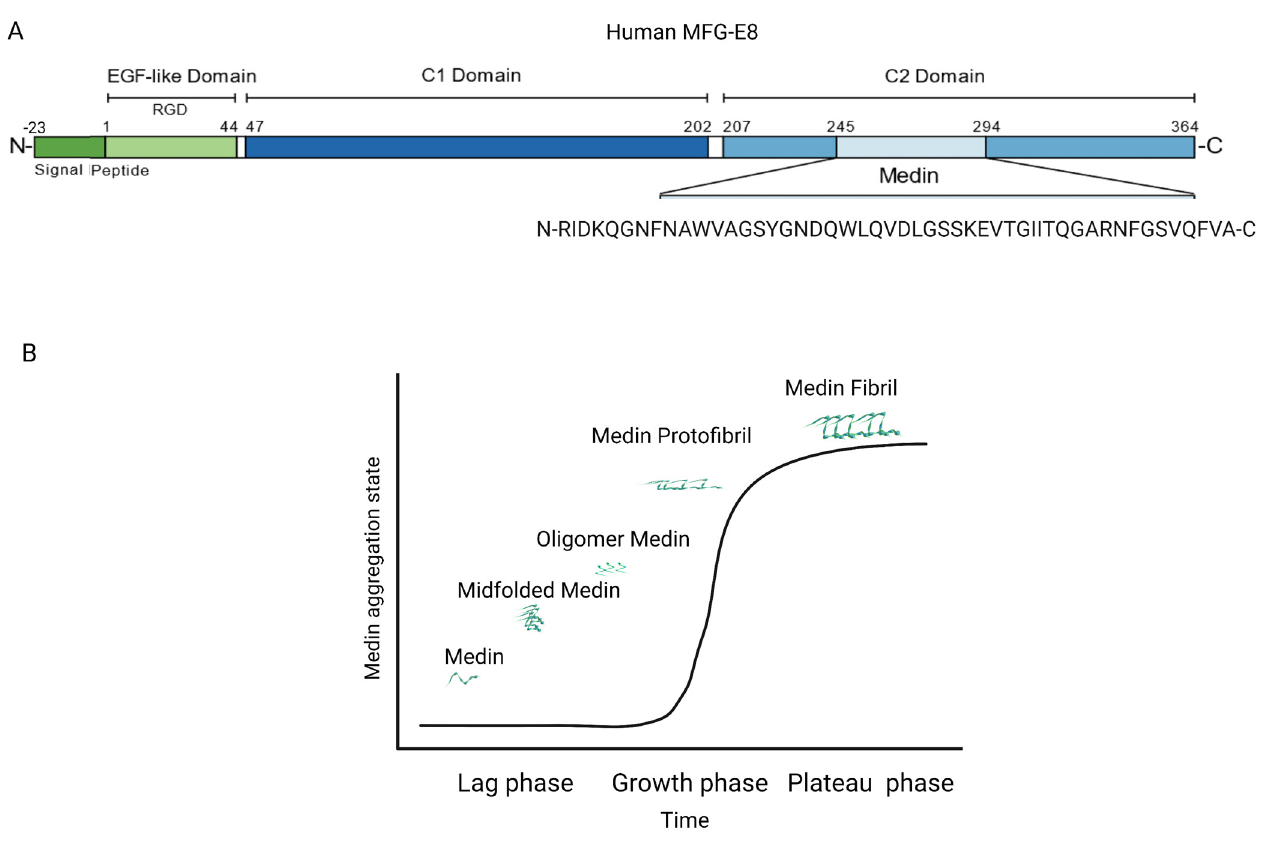
Figure 1. Schematic of MFG-E8, medin, and medin amyloid formation. ( A ) MFG-E8 is a secreted glycoprotein and is also termed lactadherin. Human MFG-E8 contains an EGF-like domain on the N-terminal side and two repeated domains homologous to blood coagulation factor V/VIII (C1 and C2 domains, respectively) on the C-terminal side. Medin is a 50-amino acid peptide cleaved by unknown mechanisms from the C2 domain of MFG-E8. ( B ) An in vitro assay of medin aggregation state in three phases: the lag phase, growth phase, and plateau phase. MFG-E8, milk fat globule EGF VIII; EGF, epidermal growth factor; C1, discoidin-like domain 1; C2, discoidin-like domain 2; RGD, an Arg-Gly-Asp motif. Created with BioRender.com.